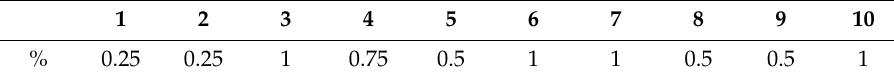
Table A3. Probability to break an existing link and create a new one.